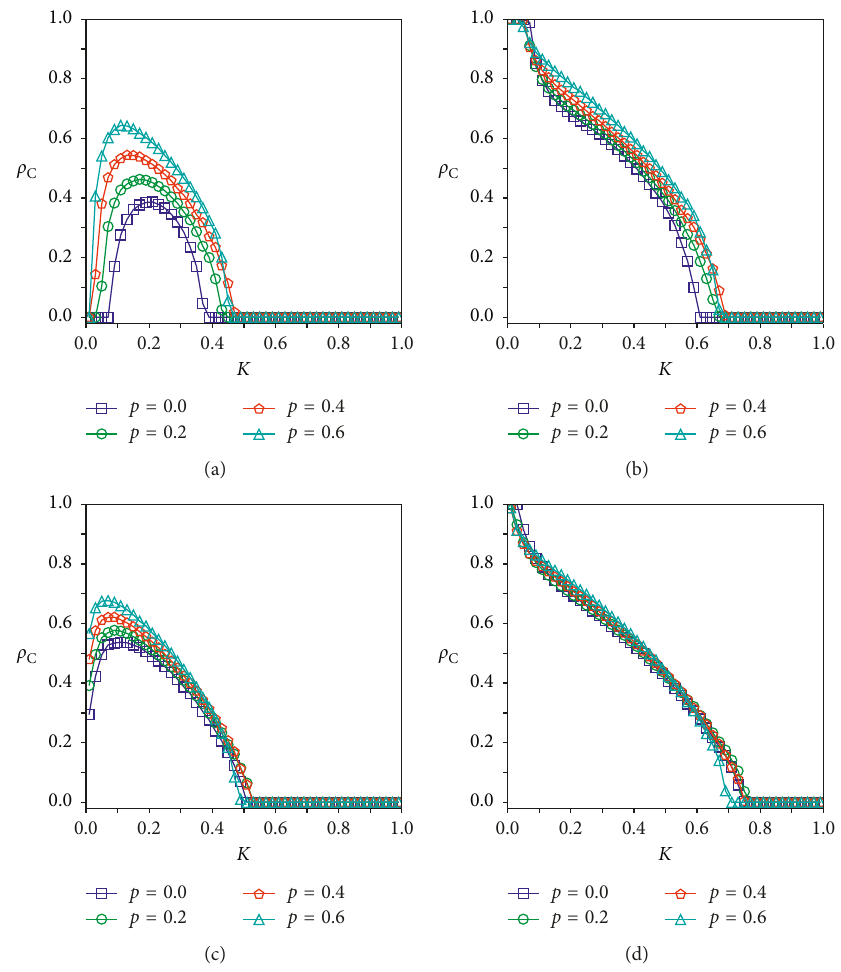
Figure 7: The cooperation level ρ as the functions of the noise level κ on the regular square lattice in the cases of r � 4 . 8 (a) and r � 5 . 2 (b) C and on WS small-world network in the cases of r � 4 . 8 (c) and r � 5 . 2 (d),